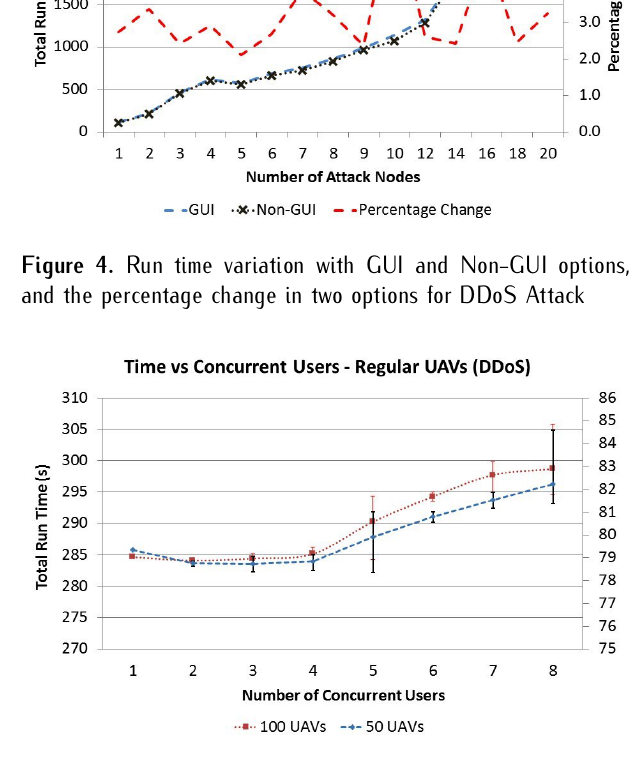
Figure 5. Run time variation of swarm simulation with increasing number of concurrent users in server mode operation for single frequency band